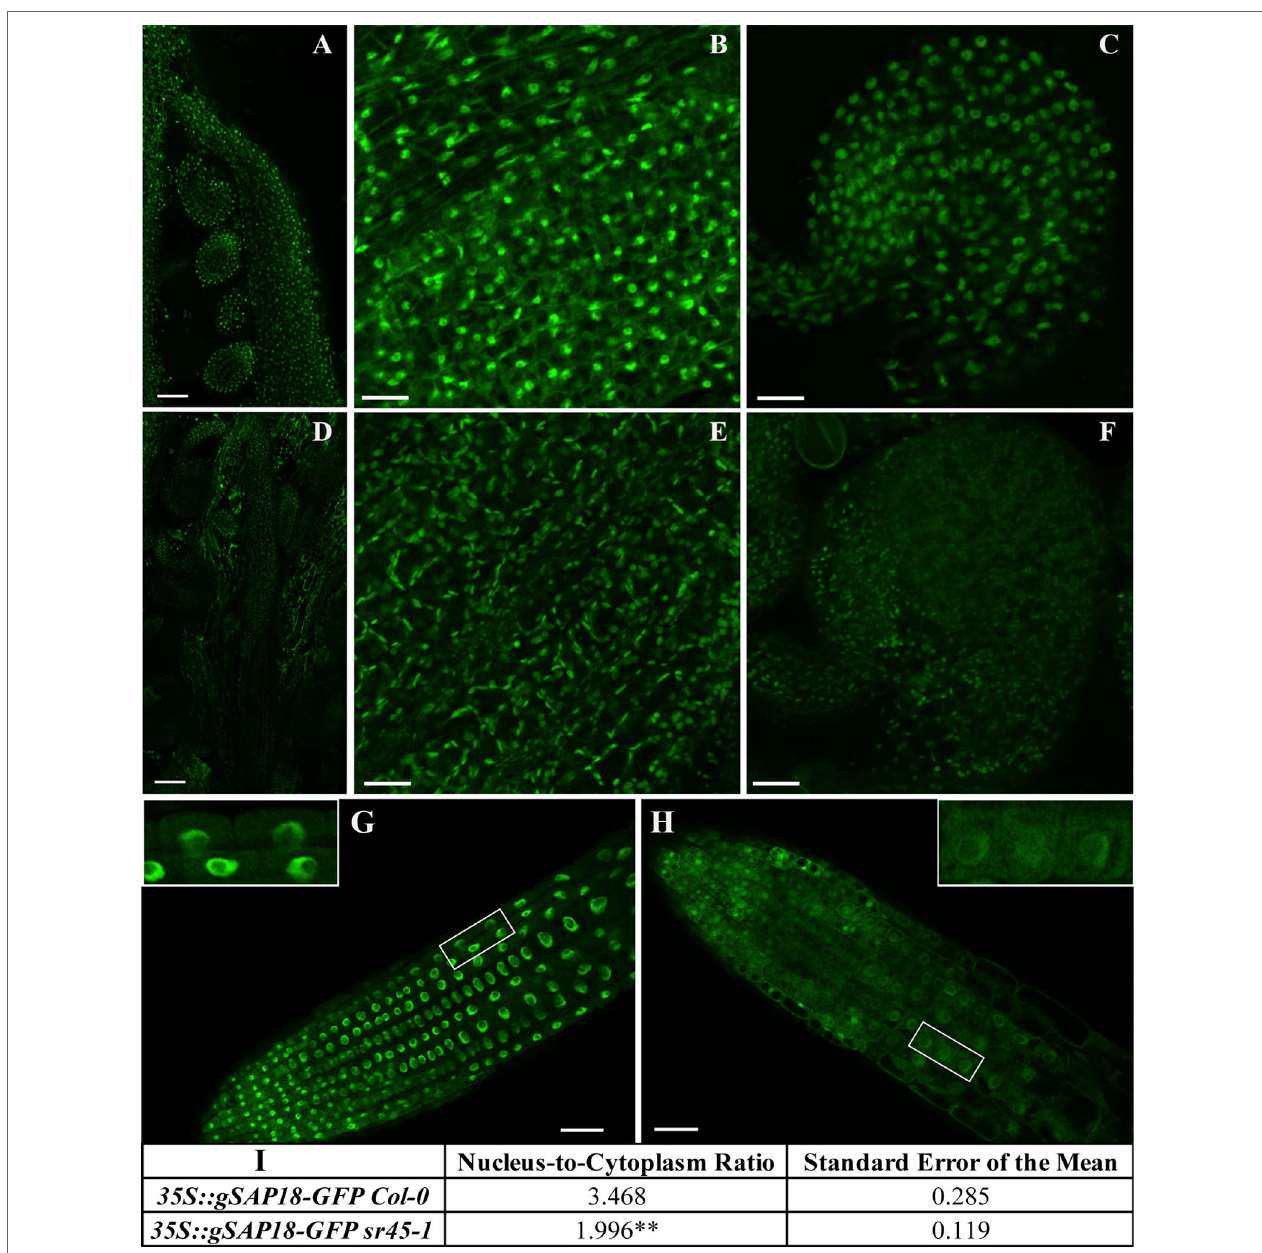
FIGURE 3 | A comparison of SAP18-GFP expression between Col-0 and sr45-1 . A-C and G represent Col-0 transgenic; D-F and H represent sr45-1 transgenic. (A) and (D) : carpel containing ovule inside with scale bars = 50 µm. (B) and (E) : a close-up view of carpel cells with scale bars = 25 µm. (C) and (F) : a close-up view of ovules with scale bars = 25 µm. (G) and (H) : root tip with scale bars = 50 µm. The inserts showed a close-up view of root cells in the boxed area. (I) : qualifications of root GFP signal intensity in nucleus vs. cytoplasm. A total of 15 cells were measured per seedling. Three seedling were used for student t-test **: p <